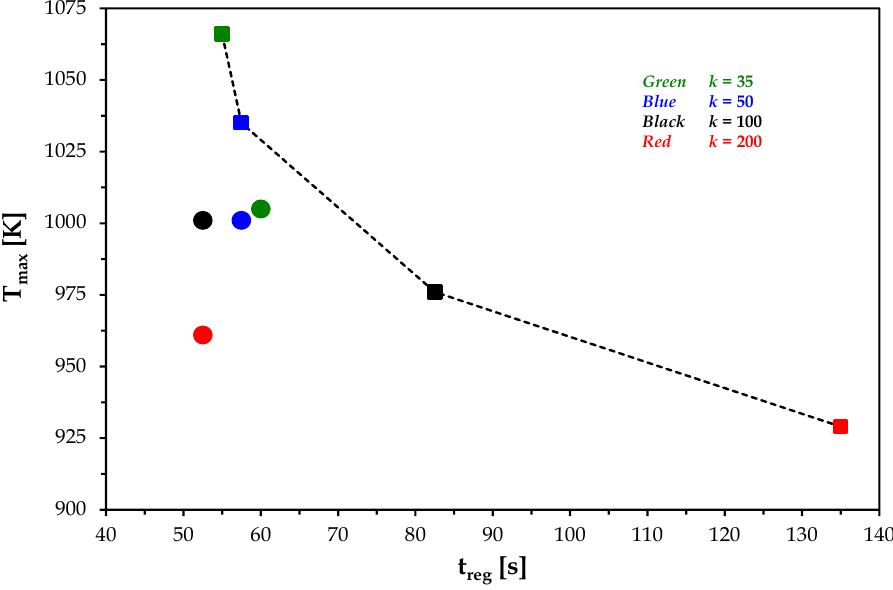
Figure 15. Operating map of the filter in the plane T max versus t reg : results at T in = T in_optimal for di ff erent values of k (circles). The lower branch of the curve at V in = 1 m / s of Figure 10 is also shown (T in = 813